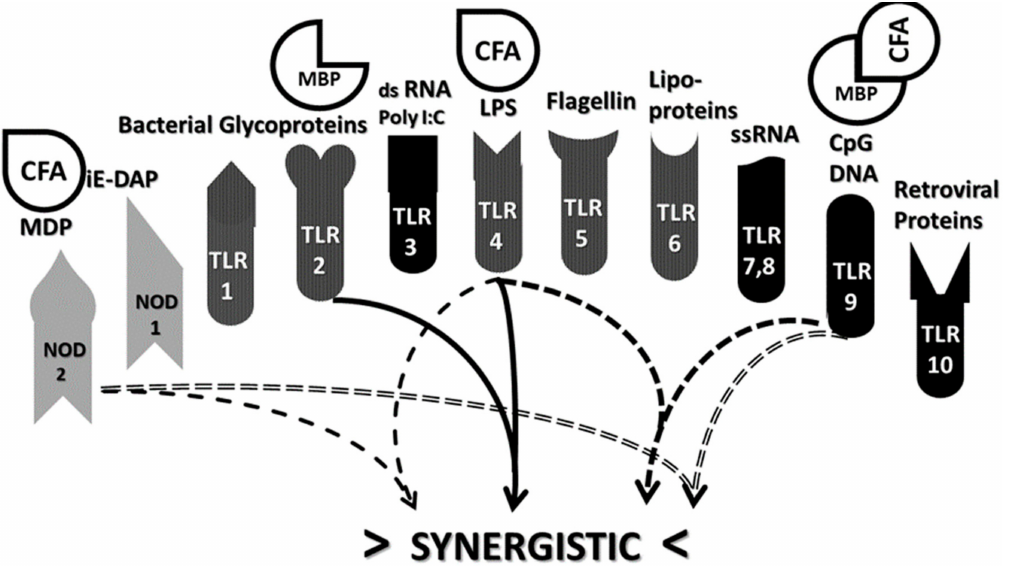
Figure 9. Schematic diagram showing the toll-like receptor (TLR) and nucleotide-binding oligomerization domain-containing protein (NOD) synergisms (Figure 7) that are expressed in multiple sclerosis (MS) and its animal model, experimental allergic encephalomyelitis (EAE). These are illustrated here by the model using complete Freund’s adjuvant (CFA) and myelin basic protein (MBP) as initiators, though the same sets of TLR / NOD activations occur in other EAE models and MS itself (Tables 1 and 2). See Figure 1 for TLR and NOD activator